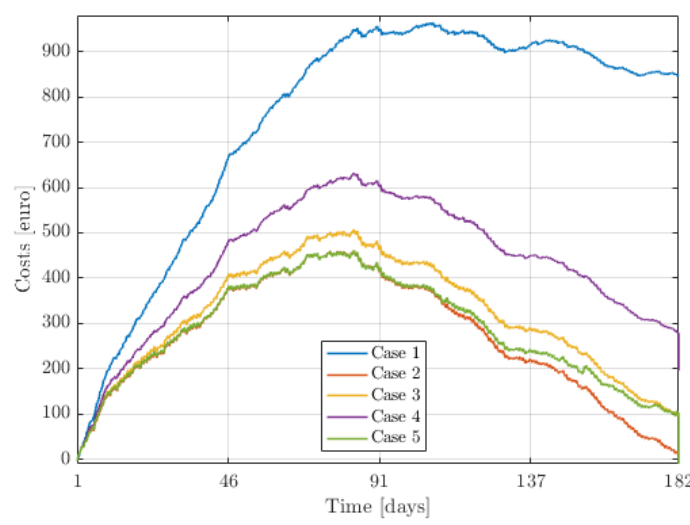
Figure 13. Total costs for all 5 cases over a half-year simulation period.